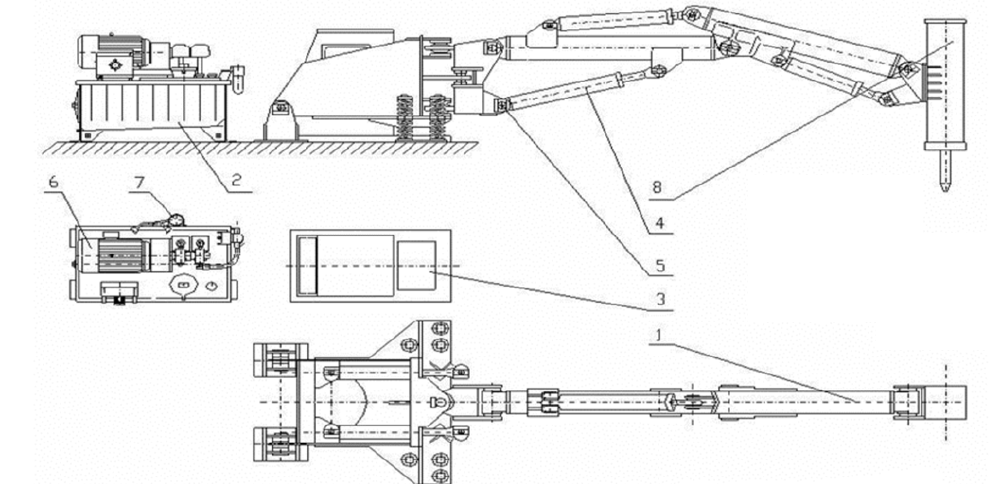
Figure 12. Typical design of hydraulic manipulator with the hydraulic hammer for crushing of oversized pieces of blasted material (KGHM ZANAM [88]) in the underground mine: 1—boom; 2— hydraulic unit; 3—air-conditioned cabin; 4—hydraulic system; 5—central control system; 6—electrical unit; 7—automatic fire extinguisher; 8—hydraulic